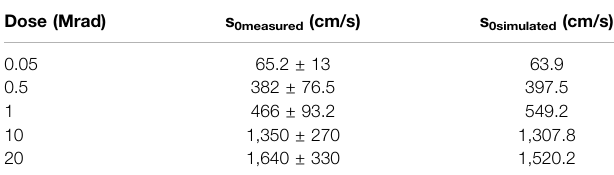
TABLE 6 | Measured and simulated surface generation velocity from FBK p-on-n